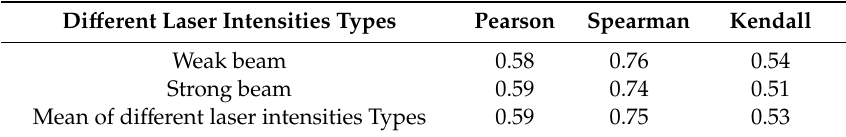
Table 6. Correlation coe ffi cient statistics between tx_pulse_energy parameters and ATLAS data. error.